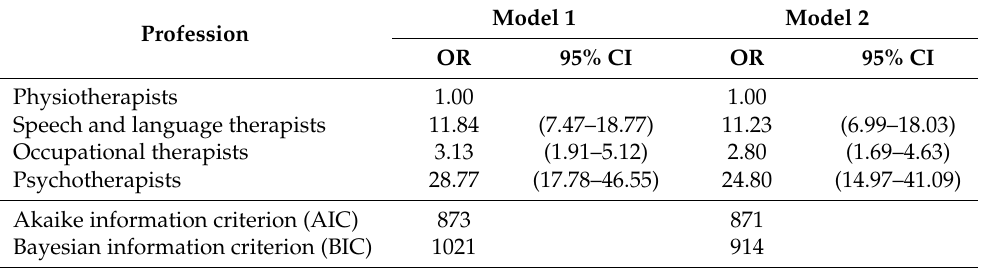
Table 3. Carried out tele-rehabilitation with most/all clients during the COVID-19 pandemic by profession, odds ratios (OR) and 95% confidence intervals (CI) ( n = 837).